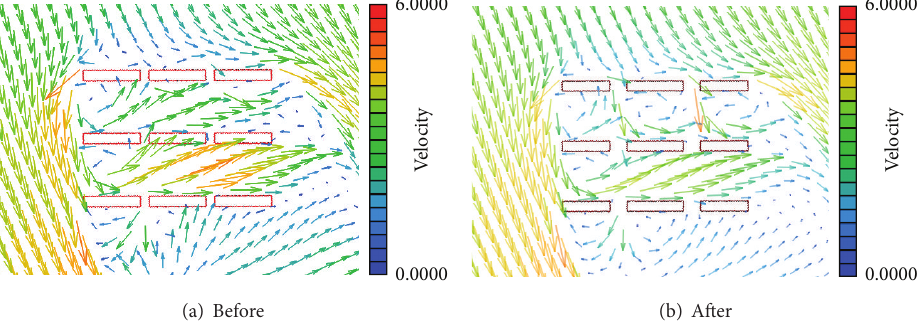
Figure 10: Results of the CFD simulation based on outer shape placement in model